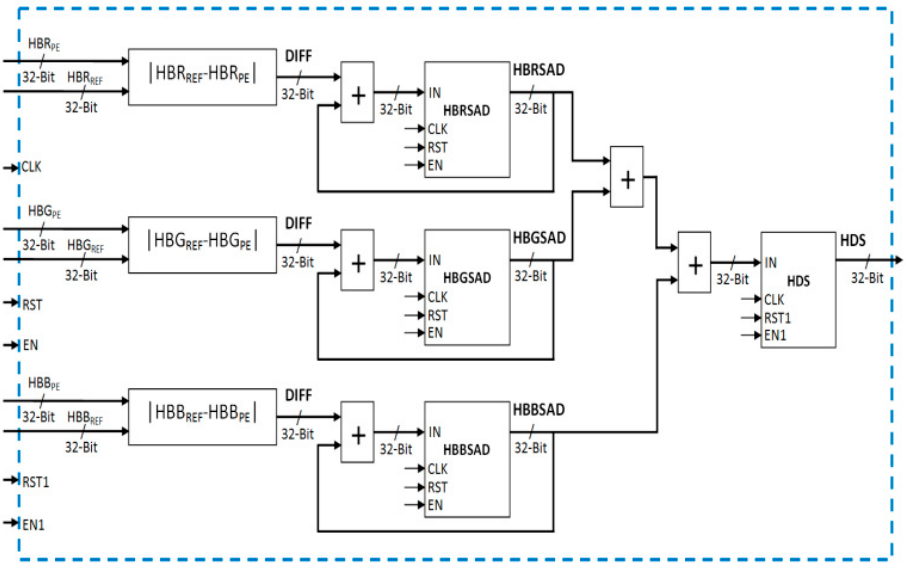
Figure 8. Architecture of Histogram Differences Sum (HDS) computation module. HB → Histogram Bin; REF → Reference; PE → Processing Element; DIFF → Difference; SAD → Sum of Absolute Differences; HDS → Sum of Absolute Differences of Histogram Bins.